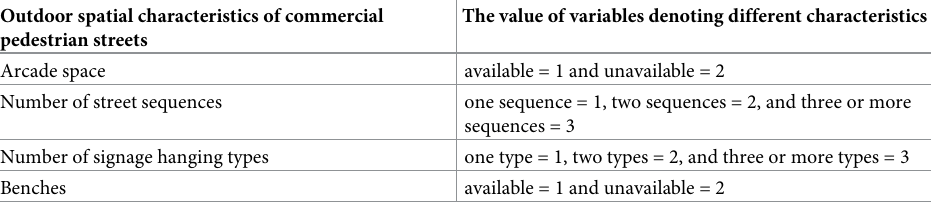
Table 1. Measurement scale of outdoor spatial